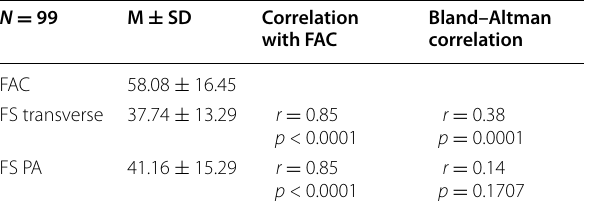
FAC (LVEDA LVESA)/LVEDA; FS = − p values for all correlations are p < 0.0001